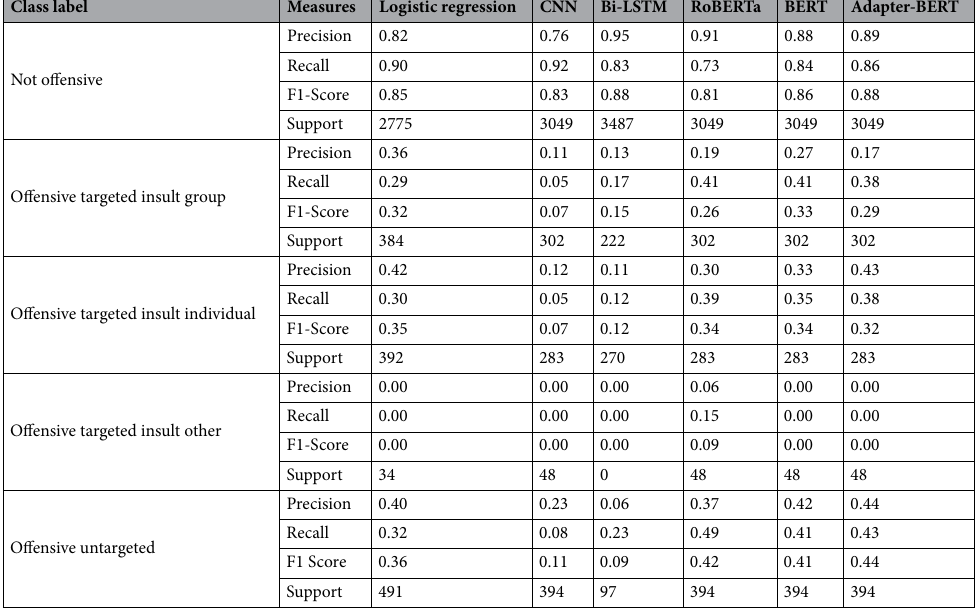
Table 5. Classification report of different models for offensive languageidentification.